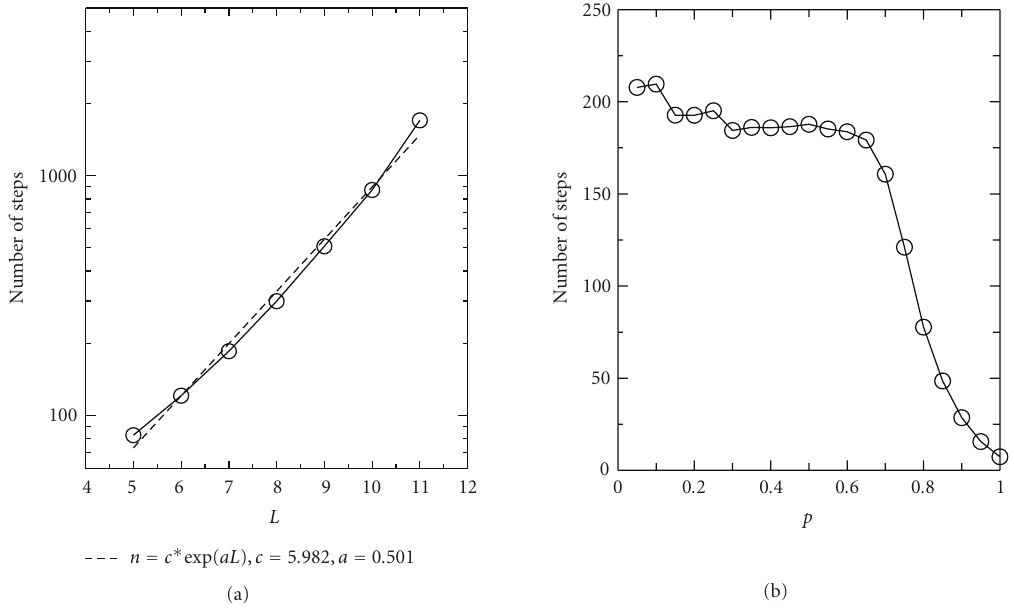
Figure 3: (a) The number of steps needed to find the optimal energy as a function of the lattice size L . The density of positive connections is fixed to P = . 4, and the parameter Δ b = 0 . 05 is used. (b) For a system with size L = 7, the number of steps needed for getting the presumed global minima is plotted as a function of the probability of positive connections p .